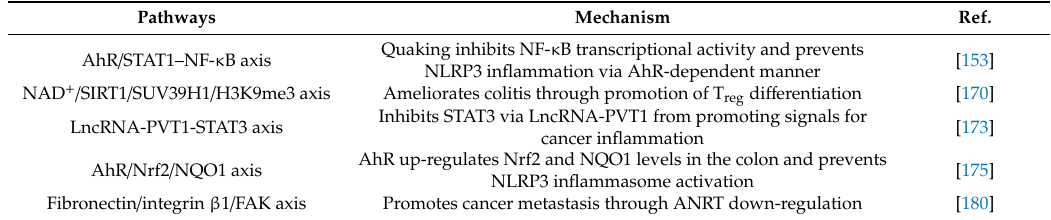
Table 1. Roles of the NLRP3 inflammasome and AhR in inflammation and cancer.